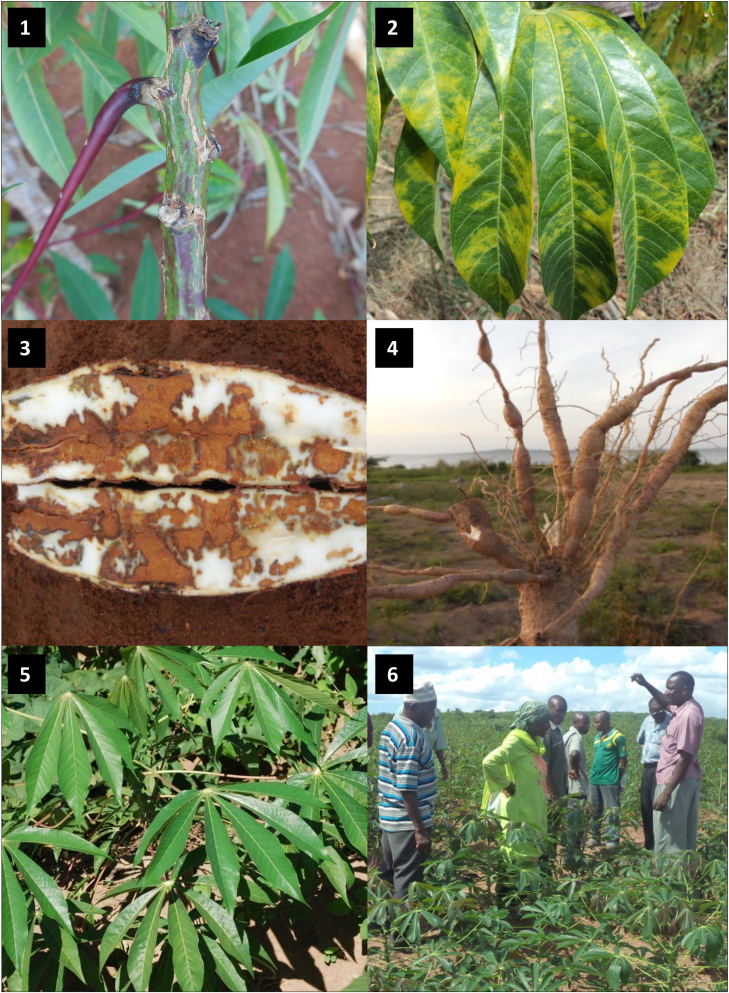
Community phytosanitation in Tanzania. 1. Necrotic lesions on cassava stem caused by CBSD; 2. Foliar symptoms of CBSD comprising a blotchy yellow chlorosis, particularly associated with secondary and tertiary veins, and most prominent on lower leaves of infected cassava plants; 3. Dry brown, corky necrosis in tuberous roots associated with severe CBSD infection; 4. Constrictions in tuberous roots which are a common feature of CBSD; 5. Healthy plants of the disease-free introduced variety − Mkombozi; 6. Community phytosanitation taskforce members explaining the objectives of the community phytosanitation initiative to cassava farmers in Chato, north-western Tanzania.